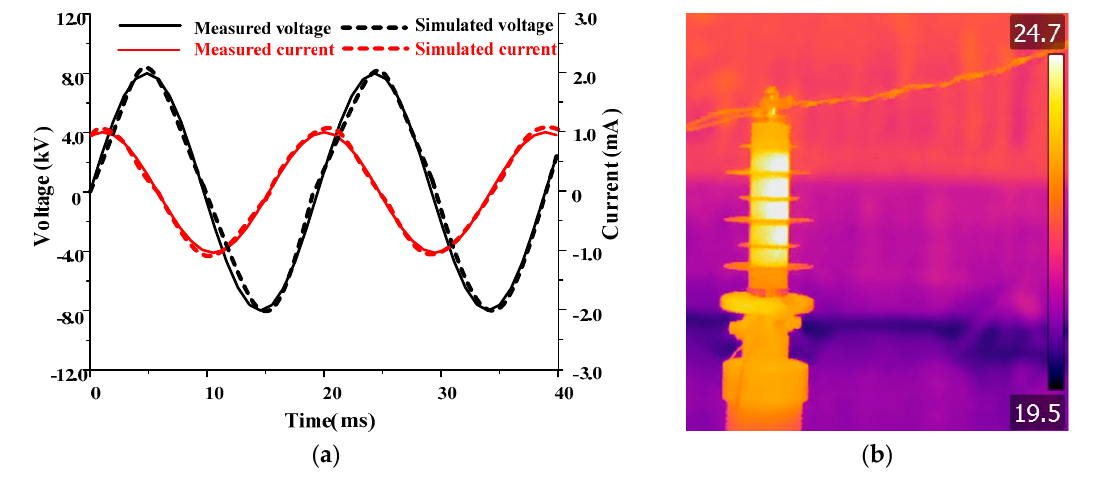
Figure 9. Electrothermal characteristics of MOA under the applied voltage of 5.8 kV. ( a ) Voltage and current time curves; ( b ) thermal picture.